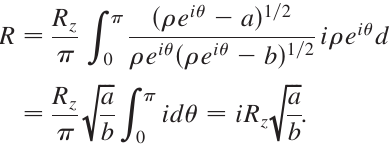
The transformation z ¼ (cid:3) ð w Þ gives a one-to-one mapping between points of the Z plane and points of the W plane and it is a conformal transform as the composition of two conformal transforms. Since (cid:3) is not invertible, we have found a good approximating function defined on three intervals and inverse of which is